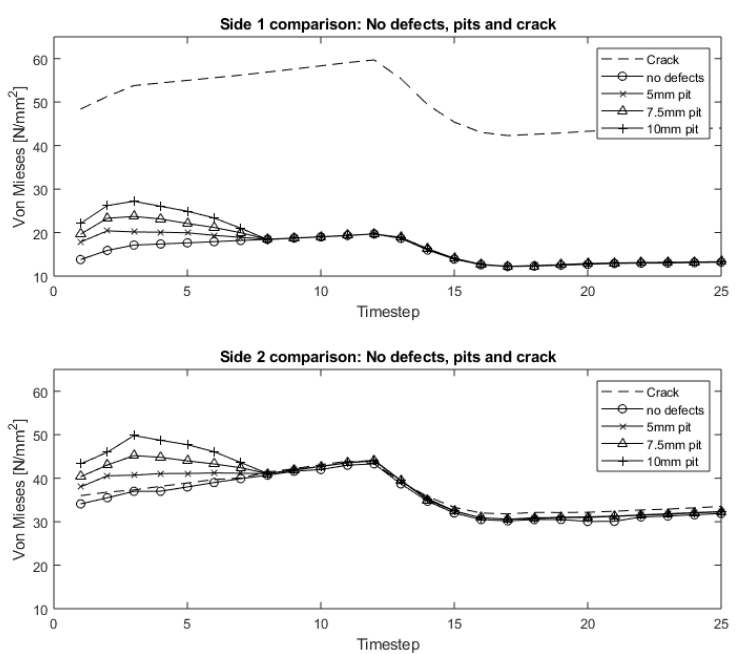
Figure 13. Side 1 ( Top ) and side 2 ( Bottom ) of all the pit simulations plotted with the crack simulations against the nominal state.